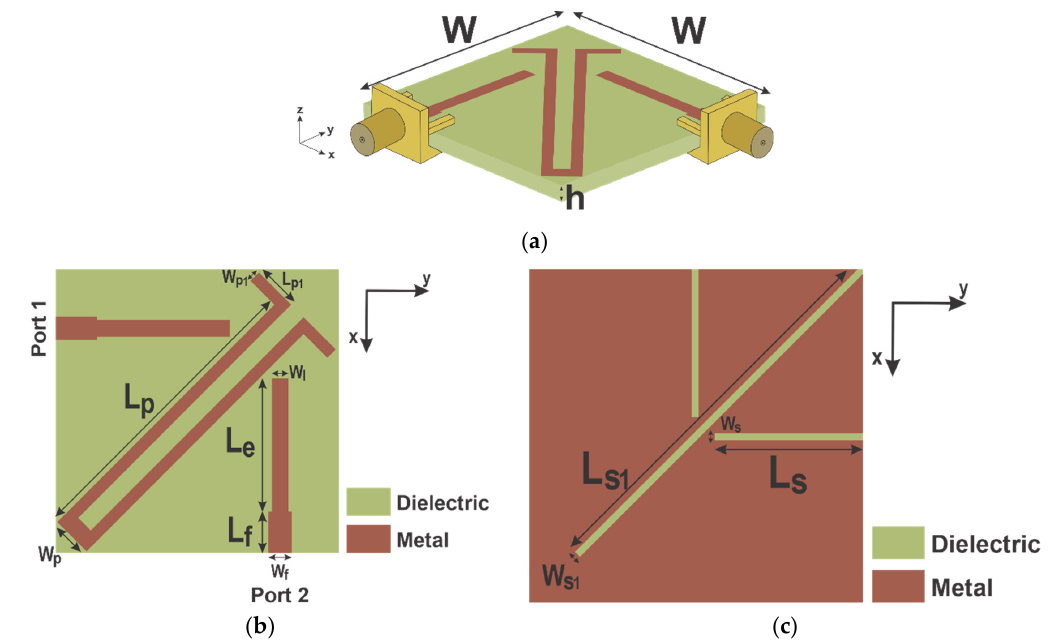
Figure 1. The proposed MIMO antenna configuration: ( a ) side view, ( b ) top view, and ( c ) bottom view.